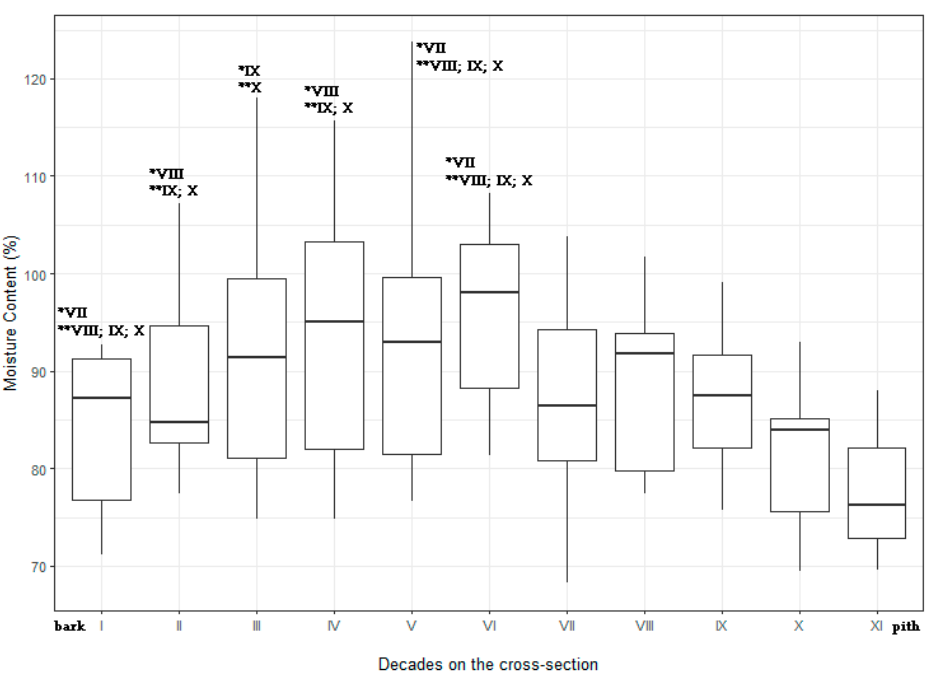
Figure 4. Changes of moisture content (%) on cross-section of the trunk from bark (section I) to pith (sections X/XI) with marked * significant and ** highly significant differences between wood samples using Tukey’s HSD test. Whiskers correspond to minimum and maximum values, boxes represent the 1st and 3rd quartile values, midlines indicate the median.